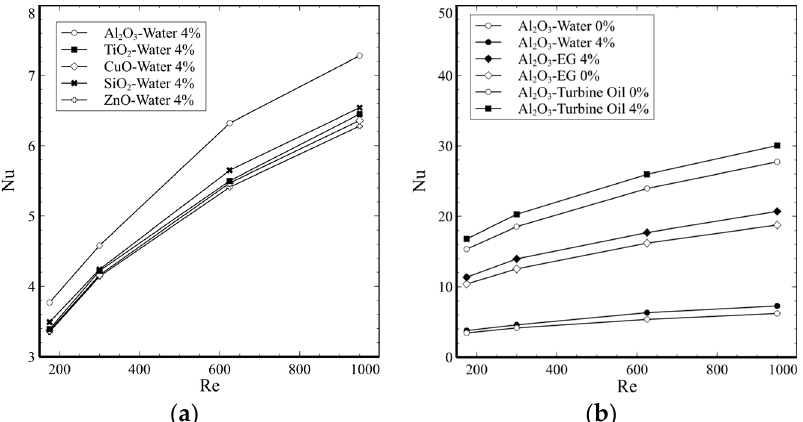
Figure 10. Comparison of Nu for: ( a ) Al 2 O 3 -water, TiO 2 -water, CuO-water, SiO 2 -water and ZnO-water and at φ b = 4%; ( b ) Al 2 O 3 -water, Al 2 O 3 -EG and Al 2 O 3 -turbine oil at φ b = 4%.